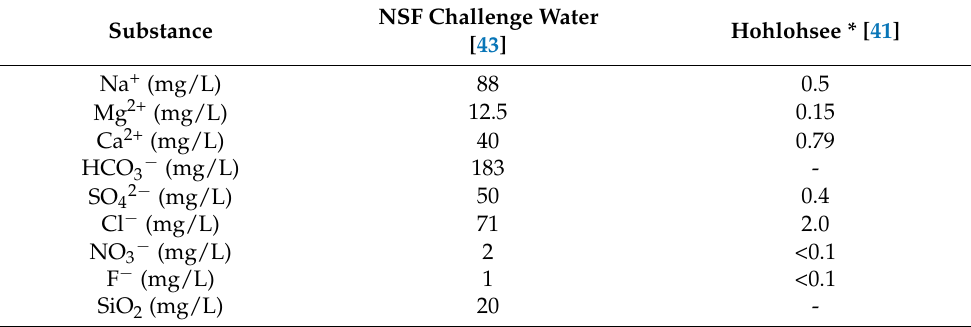
Table 1. Composition of NSF challenge water, and water from “Hohlohsee”. NSF Challenge Water Hohlohsee * [41] Substance [43] Na + (mg/L) 88 0.5 12.5